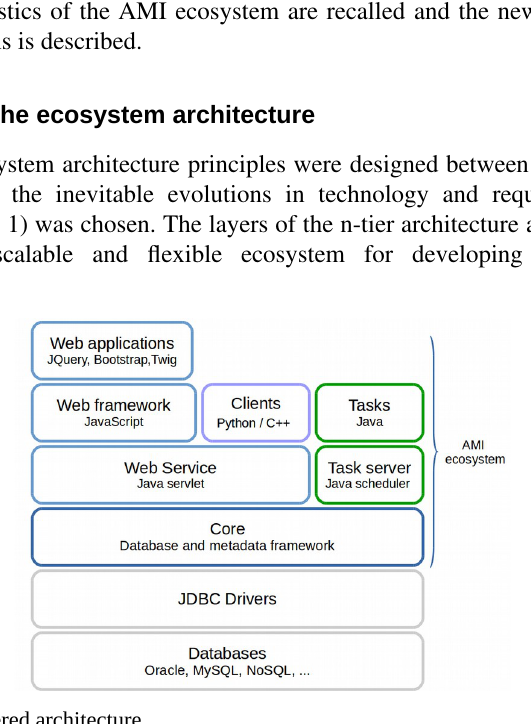
Fig. 1. AMI multilayered